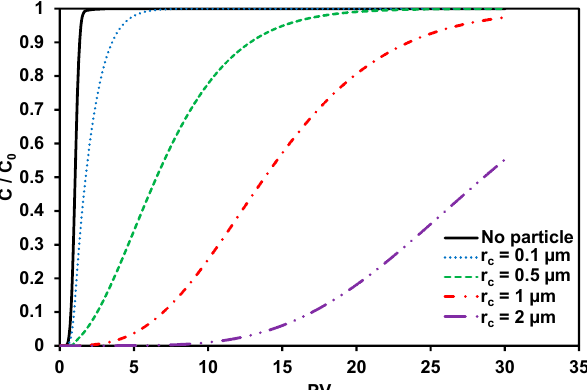
Figure 2. Simulated breakthrough curves of the contaminant at inlet colloidal particle sizes ranging from 0.1 to 2 µm.